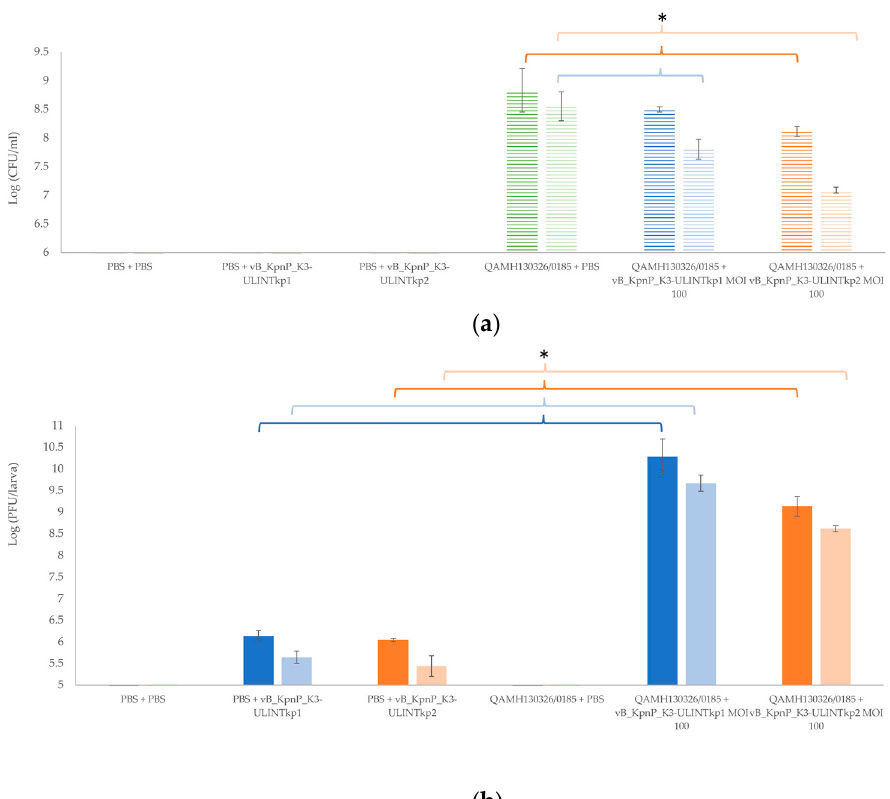
Figure 8. Bacterial (hatched chart) ( a ) and bacteriophage ( b ) titrations at 24 h (dark bars) and 72 h (light bars) after inoculation of the G. mellonella larvae in the titration experiments with the bacteriophages vB_KpnP_K3-ULINTkp1 or vB_KpnP_K3-ULINTkp2 and K. pneumoniae QAMH130326/0185. The mean of 3 titrations (± σ ) is represented. The significant results including groups with a titration equal to 0 (PFU/larvae or CFU/larvae) are not shown. MOI: multiplicity of infection. p -value (*) ≤ 0.05.